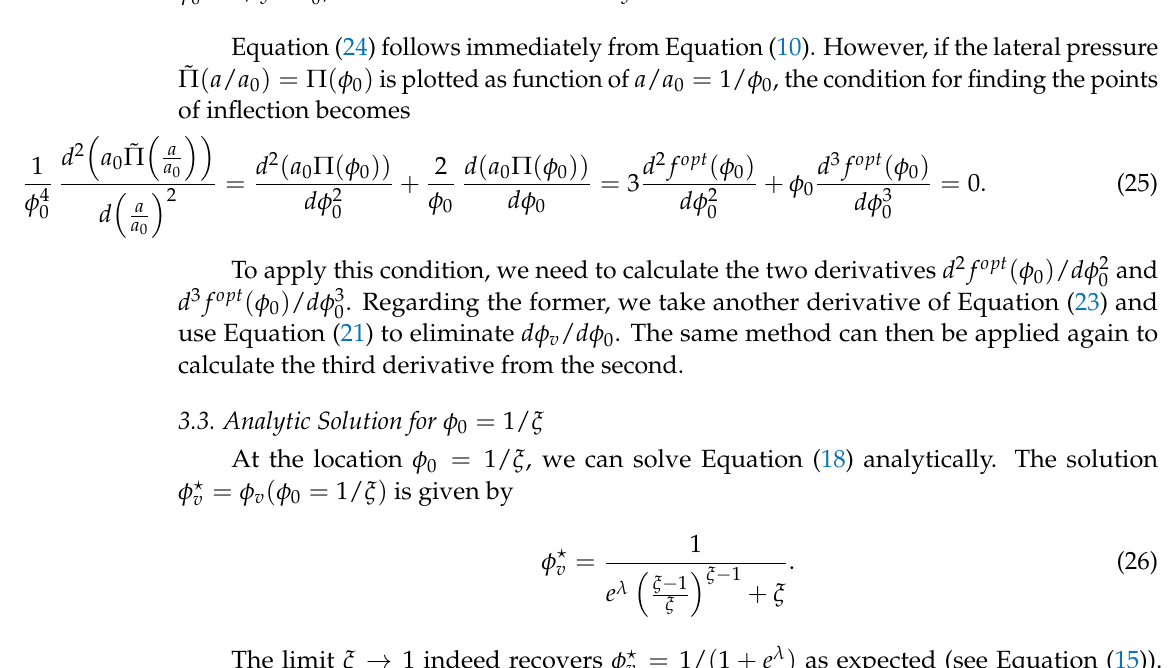
Figure 3. Diagram ( a ): Fraction of lattice sites occupied by molecules in the vertical orientation φ v = φ opt v ( φ 0 ) as a function of the (scaled) number of molecules φ 0 for λ = 0,1,2,3,4,7 (from top to bottom). Diagram ( b ): Dimensionalized pressure a 0 Π as a function of the scaled area per molecule a / a 0 for λ = 0,1,2,3,4,5,6,7,8,9 (from bottom to top). All results correspond to numerical solutions of Equation (18) and subsequent use of Equation (22). The blue circles mark the positions of the inflection points for each isotherm; the gray line that connects the blue circles marks the set of all inflection points that exist for λ ≤ 9. The black crosses display the lateral pressures at positions φ 0 = 1/ ξ = a 0 / a . All results are derived for ξ =